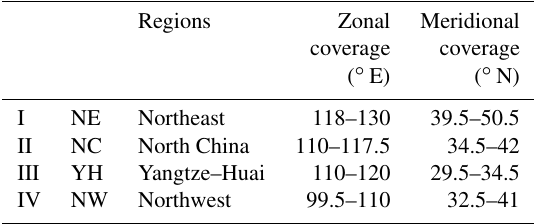
Table 2. Names and spatial coverage of the selected research re-